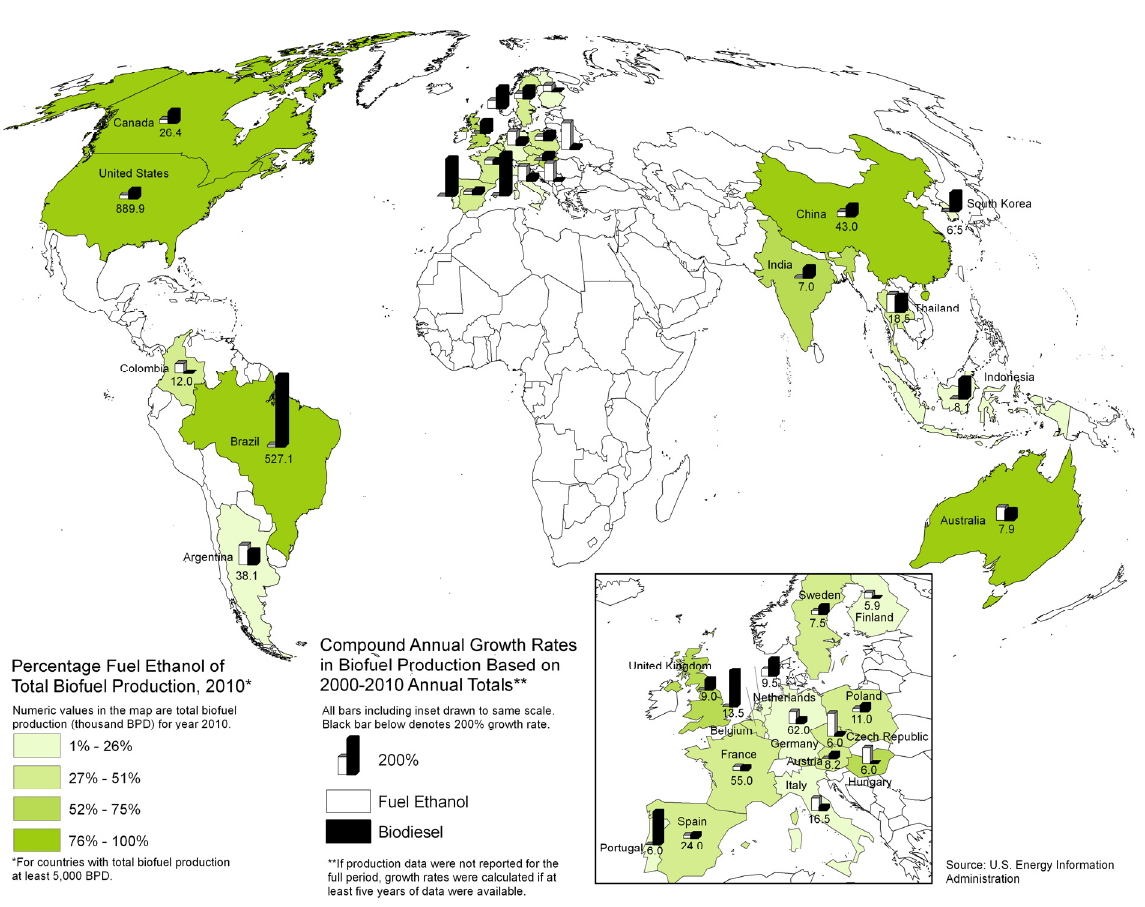
Figure 2. Share of ethanol in total biofuel production, 2010; and growth in total biofuel